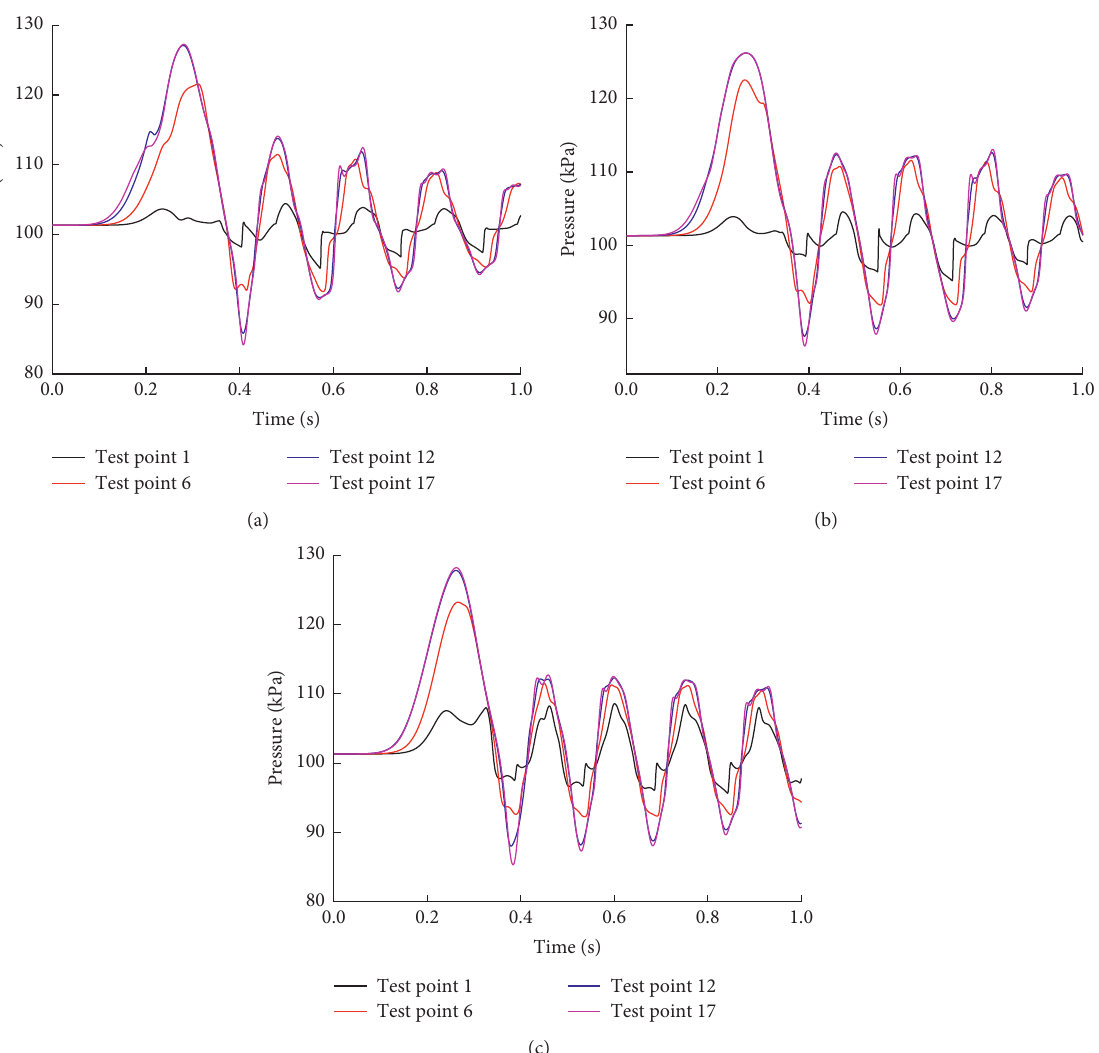
Figure 4: Curves of pressure vs. time under different ignition positions. (a) Top ignition. (b) Center ignition. (c) Bottom